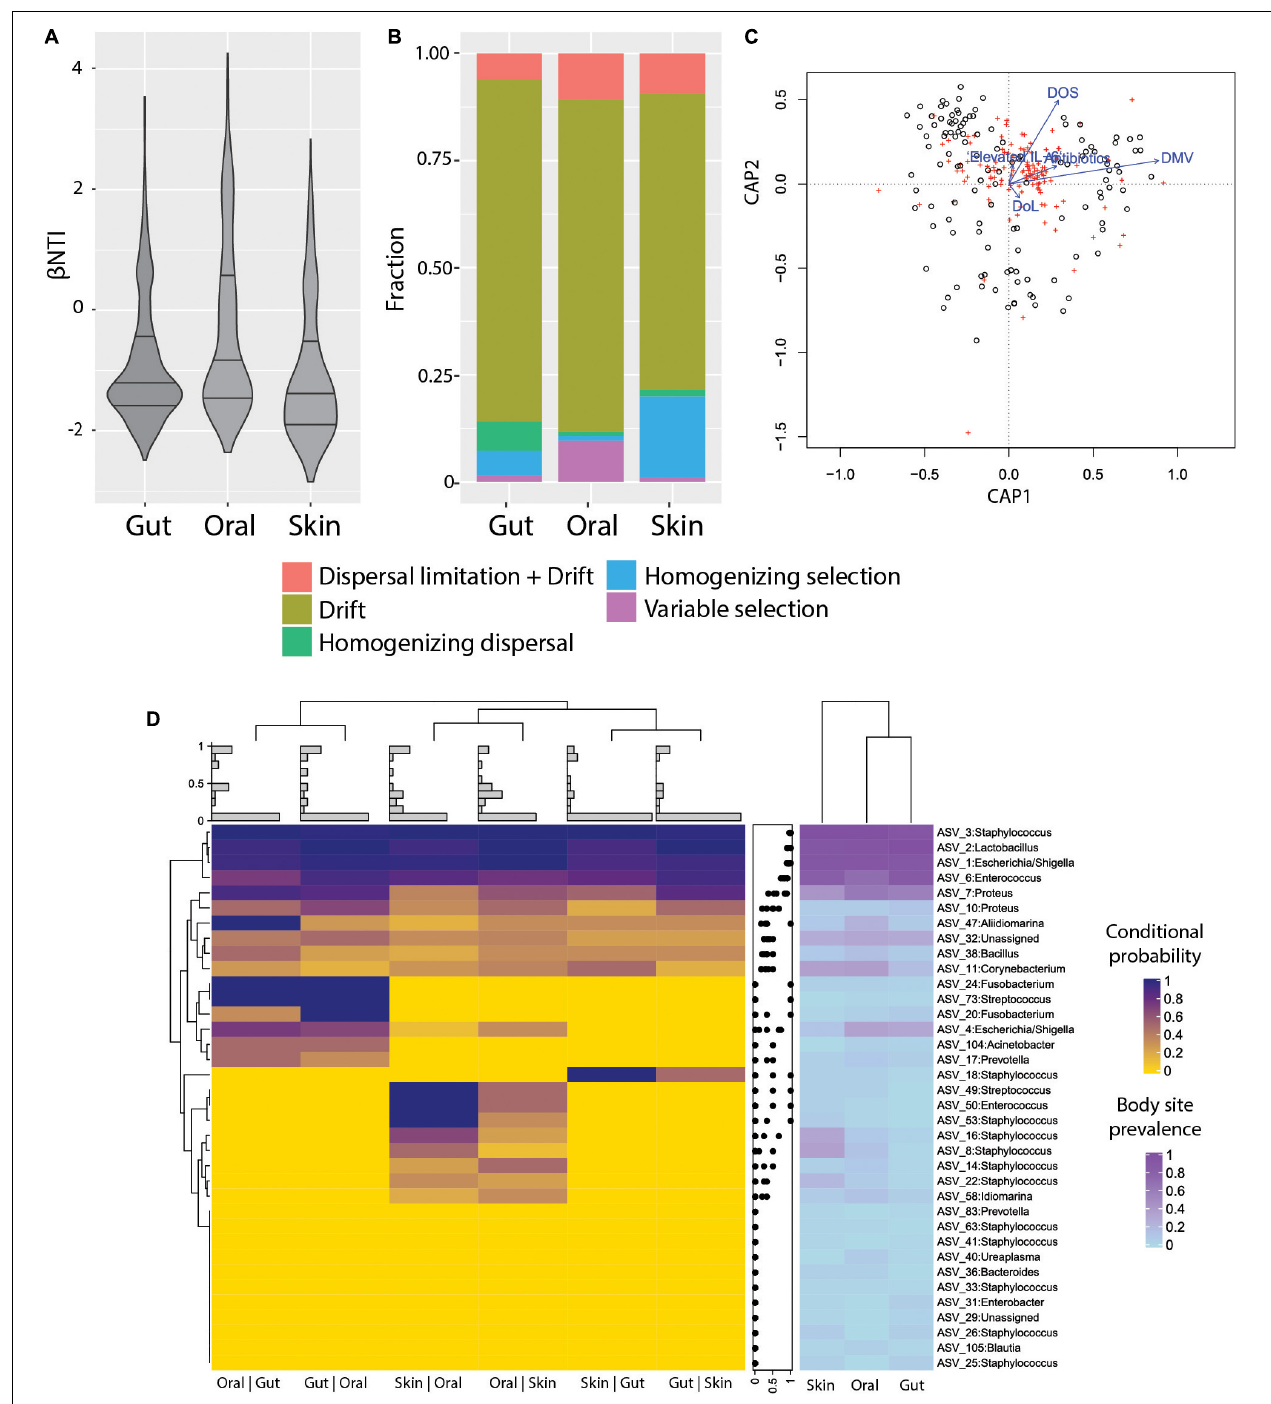
FIGURE 3 | Ecological processes and microbiome assembly. (A) β NTI (beta Nearest Taxon Index) per body site. β NTI greater than + 2 standard deviations from the null-model indicate variable selection pressures; scores near zero indicate dominance of stochastic processes; and scores less than -2 standard deviations indicate homogeneous selective pressures. (B) Fraction of ecological processes predicted for each body site. (C) Canonical correlation analysis (CCA) plot, showing the relative proportion of β NTI variance explained by DMV, DOS, Elevated IL-6, Antibiotics, and DoL (proportion of constrained variance = 0.04). DoL, days of life; Elevated IL-6, IL-6 > 150 pg/ml in the time window of 2 days before to 2 days after sampling; DOS, number of days with at least 12 h per day of FiO 2 > 21% up to the day of sampling; DMV, days with mechanical ventilation support till the day of sampling. Antibiotics = cumulative index for days of antibiotic administration accounting for different compounds per day. (D) Heatmap of conditional probability to detect an ASV at a body site when present at another (left). Distribution of values for each row (center). Heatmap for ASV prevalence in each body site (right).